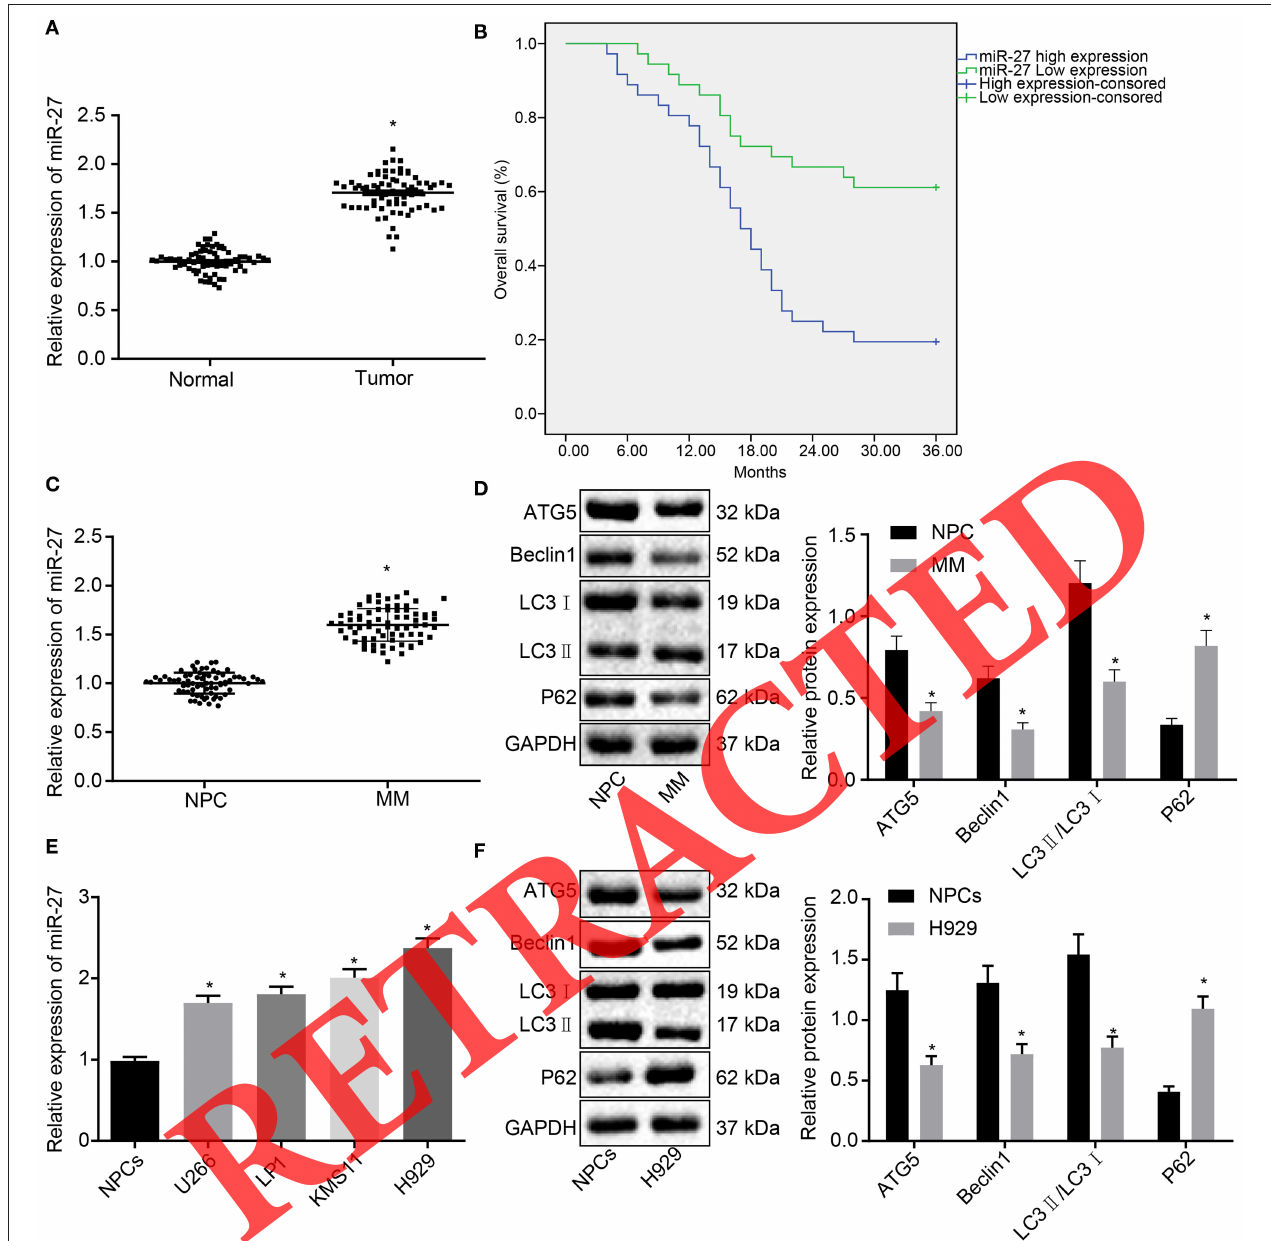
FIGURE 1 | miR-27 is overexpressed in MM tissues and cells and is related to the poor prognosis of patients. (A) , miR-27 expression in bone marrow of MM patients ( n = 72) and healthy donors ( n = 72) detected by RT-qPCR. * p < 0.05 compared with bone marrow of healthy donors. (B) , The correlation between miR-27 expression and OS of the patient ( n = 72) analyzed by Kaplan–Meier. (C) , The expression of miR-27 in bone marrow plasma cells from MM patients and NPCs detected by RT-qPCR ( n = 72). * p < 0.05 compared with NPCs. (D) , Western blot analysis of the protein expression of autophagy-related proteins (ATG5, Beclin1, LC3 II/LC3 I, and P62) in bone marrow plasma cells from MM patients and NPCs. * p < 0.05 compared with NPCs. (E) , miR-27 expression in NPCs, U266, LP1, KMS11, and H929 detected by RT-qPCR. * p < 0.05 compared with NPCs. (F) , The protein expression of autophagy-related proteins (ATG5, Beclin1, LC3 II/LC3 I, and P62) in H929 cells and NPCs detected by western blot analysis. * p < 0.05 compared with NPCs. The data were measurement data and expressed as mean ± standard deviation. Unpaired t -test was used for comparison between two groups, and one-way ANOVA was used for comparison among multiple groups. The cell experiment was repeated three